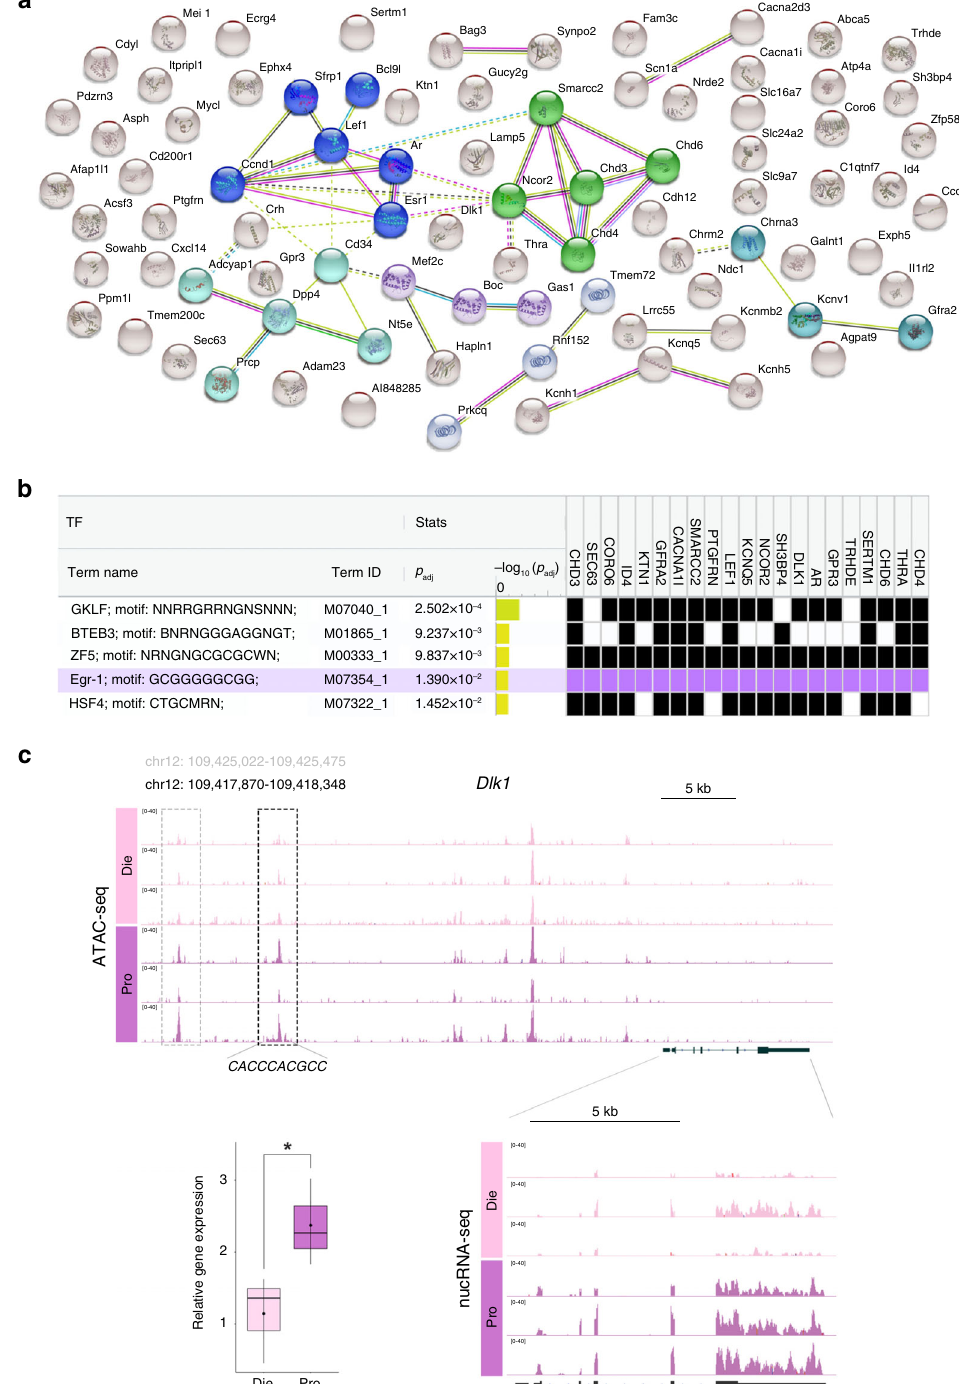
Fig. 5 Chromatin remodelling- and anxiety-relevant genes show differential expression and varying chromatin accessibility across the oestrous cycle. a Shown are all genes with differential expression and local changes in ATAC-seq peak formation in the proestrus – dioestrus comparison; the connections between gene products highlighting fi ve major gene clusters are shown using String. Of note is the main cluster corresponding to the chromatin remodelling factors (green). b The top fi ve transcription binding sites identi fi ed in the vicinity of the TSS of the above genes (focused on the genes that contain an Egr1 binding site). c Chromatin accessibility (ATAC-seq) and nucRNA expression pro fi le of Dlk1 in dioestrus and proestrus. Shown are the genomic coordinates of the two differential ATAC-seq peaks, predicted Egr1 binding sequence within the second ATAC-seq peak, the IGV track of the nucRNA-seq data, and a boxplot showing qPCR validation of the nucRNA-seq data). ( n = 3 biological replicates/group); boxplots (box, 1st – 3rd quartile; horizontal line, median; whiskers, min/max; inner circles, mean ±SEM); * p < 0.05 (unpaired t test, one-tailed). Die (light pink), dioestrus; Pro (purple),